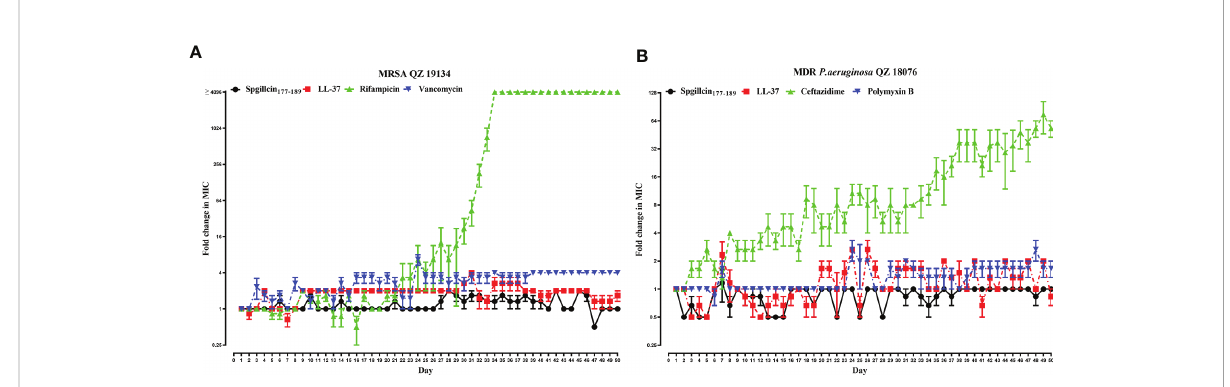
FIGURE 10 Spgillcin 177 – 189 killed MRSA and MDR P. aeruginosa without resistance selection. (A) Resistance development of MRSA QZ19134 after continuous Spgillcin 177 – 189 , LL-37, rifampicin, and vancomycin treatment. (B) Resistance development of MDR P. aeruginosa after continuous Spgillcin 177 – 189 , LL-37, ceftazidime, and polymyxin B treatment. The y-axis values represented fold change (in log 2 ) in minimum inhibitory concentration (MIC) relative to the MIC of the fi rst day during serial passage, and the x-axis showed the number of